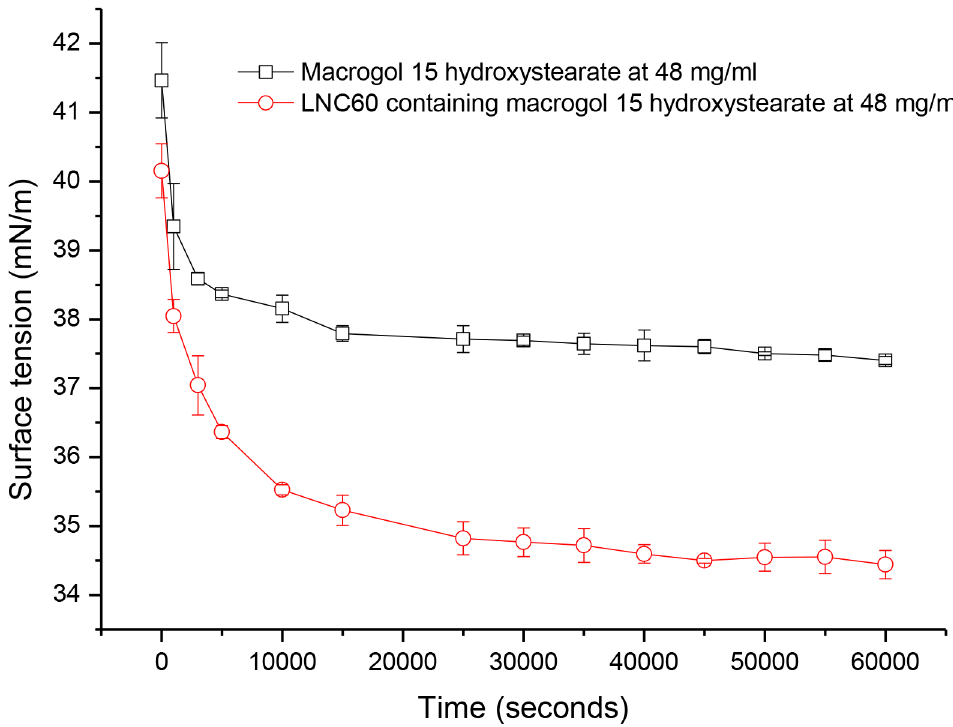
Fig 2. Surface tension versus time of the MHS solution (50 mM) and LNC dispersion containing 50 mM MHS as determined by drop tensiometry.